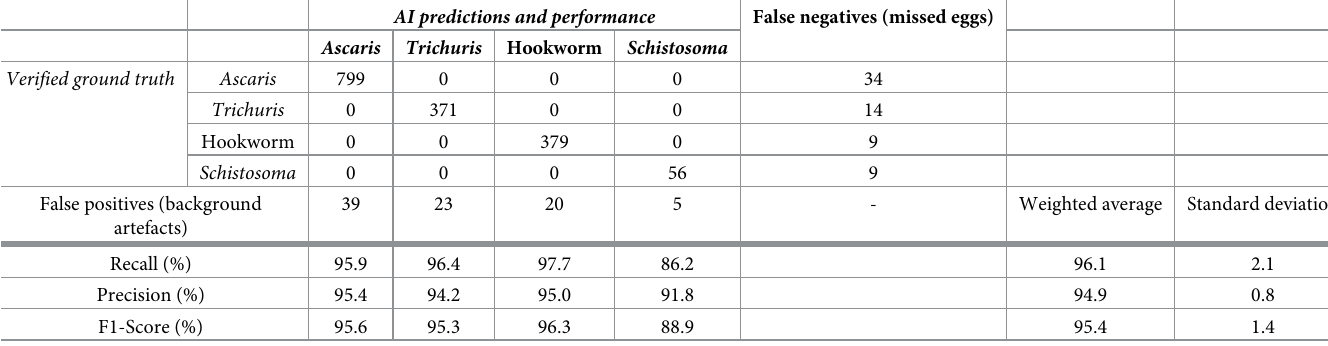
Table 3. Confusion matrix and performance measures for STH and SCH AI